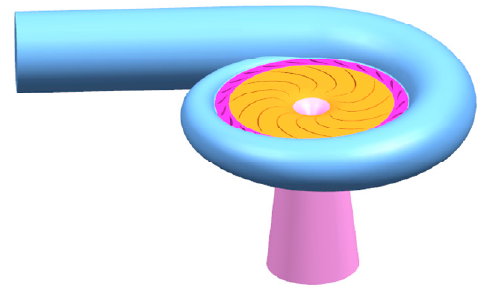
Figure 3. Computational domain of the LSST.